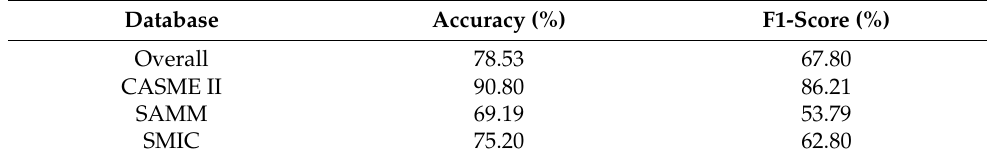
Table 6. ME recognition performance of OC-Net.